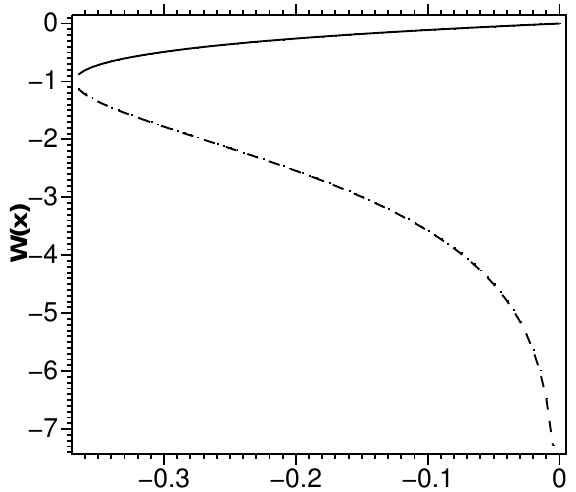
Fig. 4. Lambert’s W -function W(x) for negative argument. Both principal (solid) and non-principal (dashed) branches are